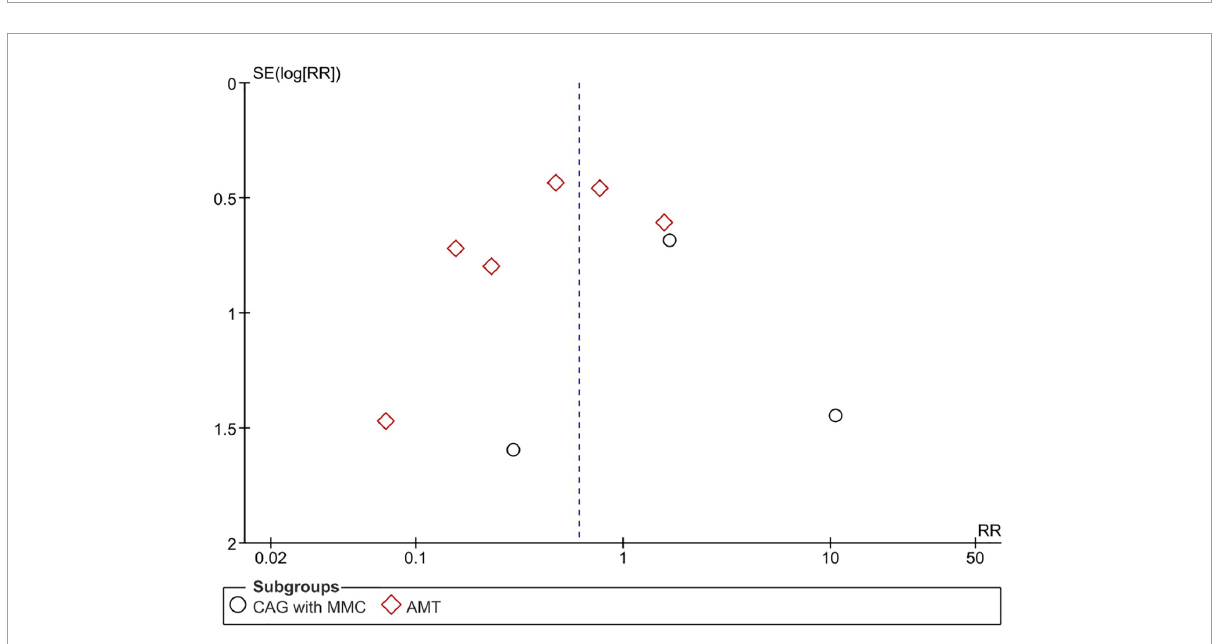
FIGURE8 Funnel plot of adverse events. SE, standard error; RR, risk ratio; CAG, conjunctival autograft; AMT, amniotic membrane transplantation; MMC, mitomycin